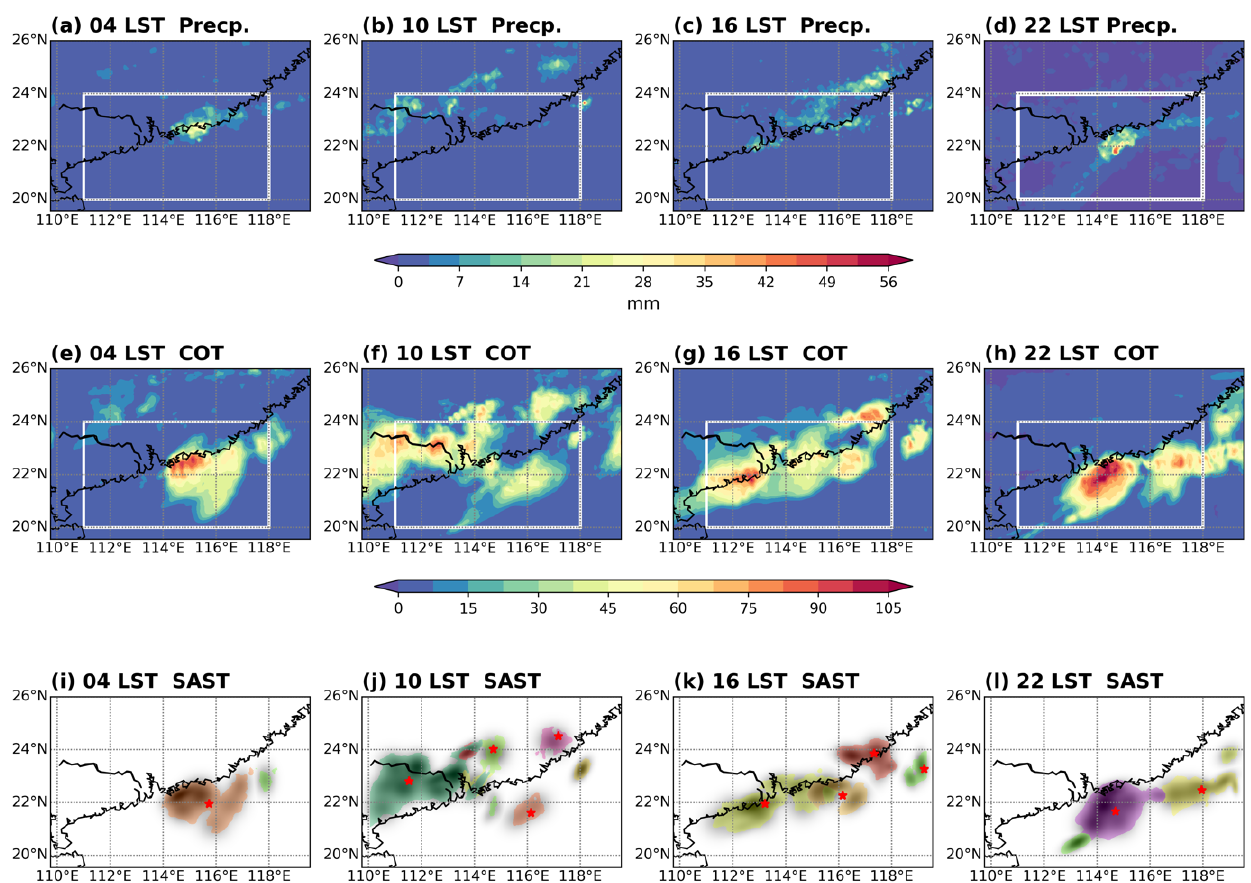
Figure 9. One-day case (6 h intervals) showing the SAST tracking results on each input frame. The first row ( a – d ) shows the precipitation patterns, the second row ( e – h ) shows the ICOT images, and the last row ( i – l ) shows the MCSs tracked using the SAST method and ICOT images as input. The identified convection centers are denoted by red stars, and all times are consistent for each column among these three rows.